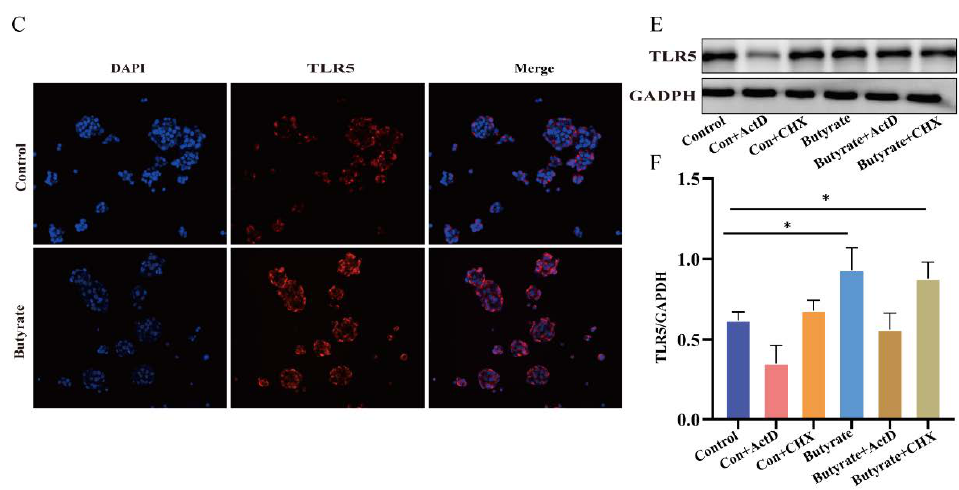
Figure 5. Butyrate increases TLR5 transcriptional expression in HT29 cells. RT–qPCR shows TLR5 mRNA expression in HT29 cells treated with a physiological concentration of butyrate (1 to 8 mM) for 24 h ( A ) or with 4 mM butyrate for a specific duration ( B ). ( C ) Immunofluorescence images of TLR5 in the control and butyrate groups; the butyrate treatment conditions were 4 mM for 24 h. ( D ) The change in TLR5 mRNA expression from adding transcription inhibitors ortranslation inhibitors in the control and butyrate groups. ( E ) Representative Western blot analysis showing TLR5 expres- sion after the addition of transcription inhibitors or translation inhibitors to the control and butyrate groups. ( F ) Quantitative analysis of Western blot analysis. * p < 0.05, ** p < 0.01, and *** p < 0.001.